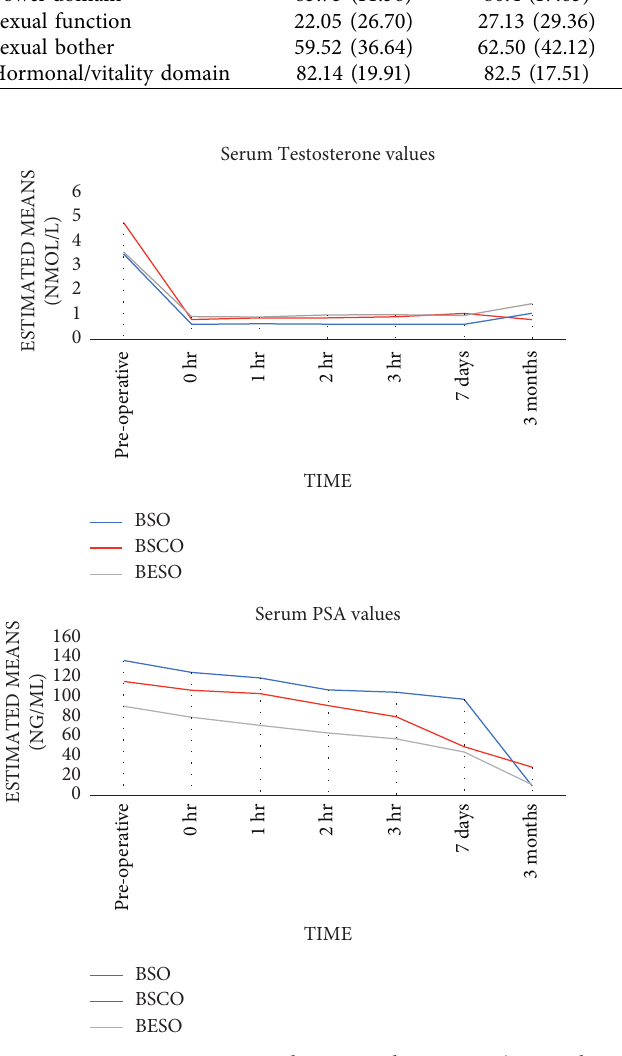
Figure 6: Comparison of the postoperative (a) RV pseudotesticular